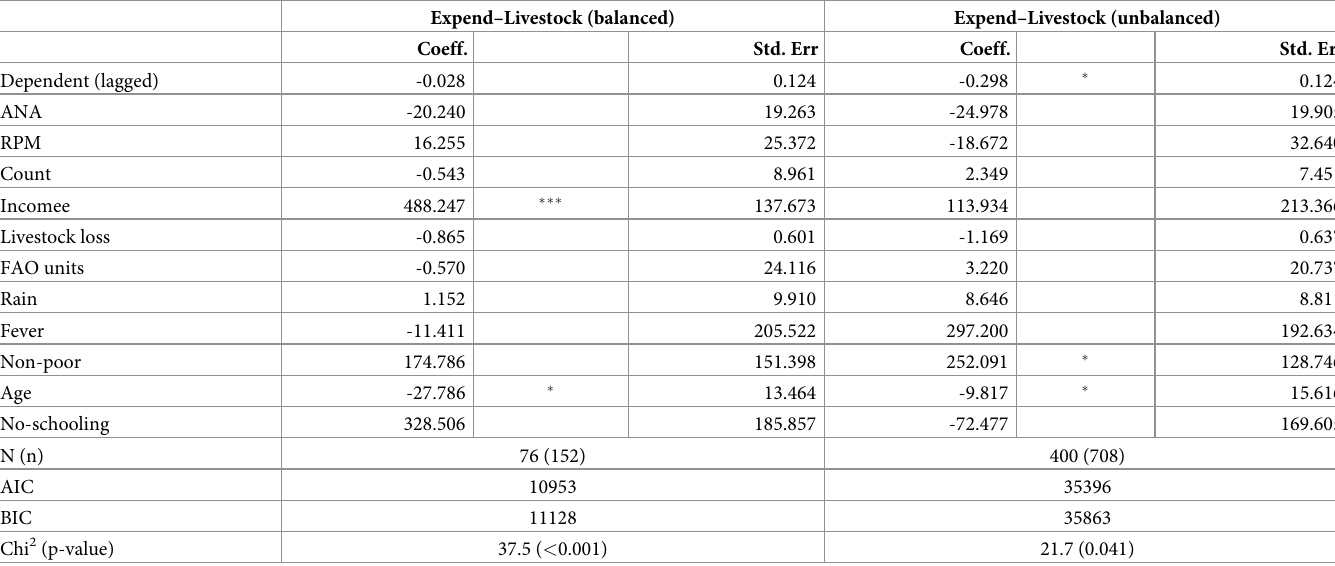
Table 5. Livestock expenditure–balanced and unbalanced